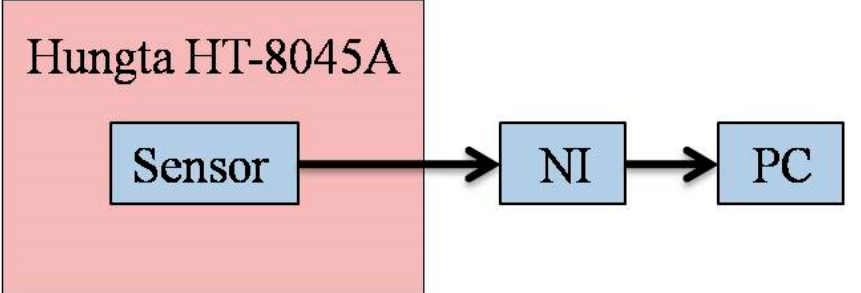
Figure 8. Schematic diagram of calibration of the flexible micro humidity sensor.